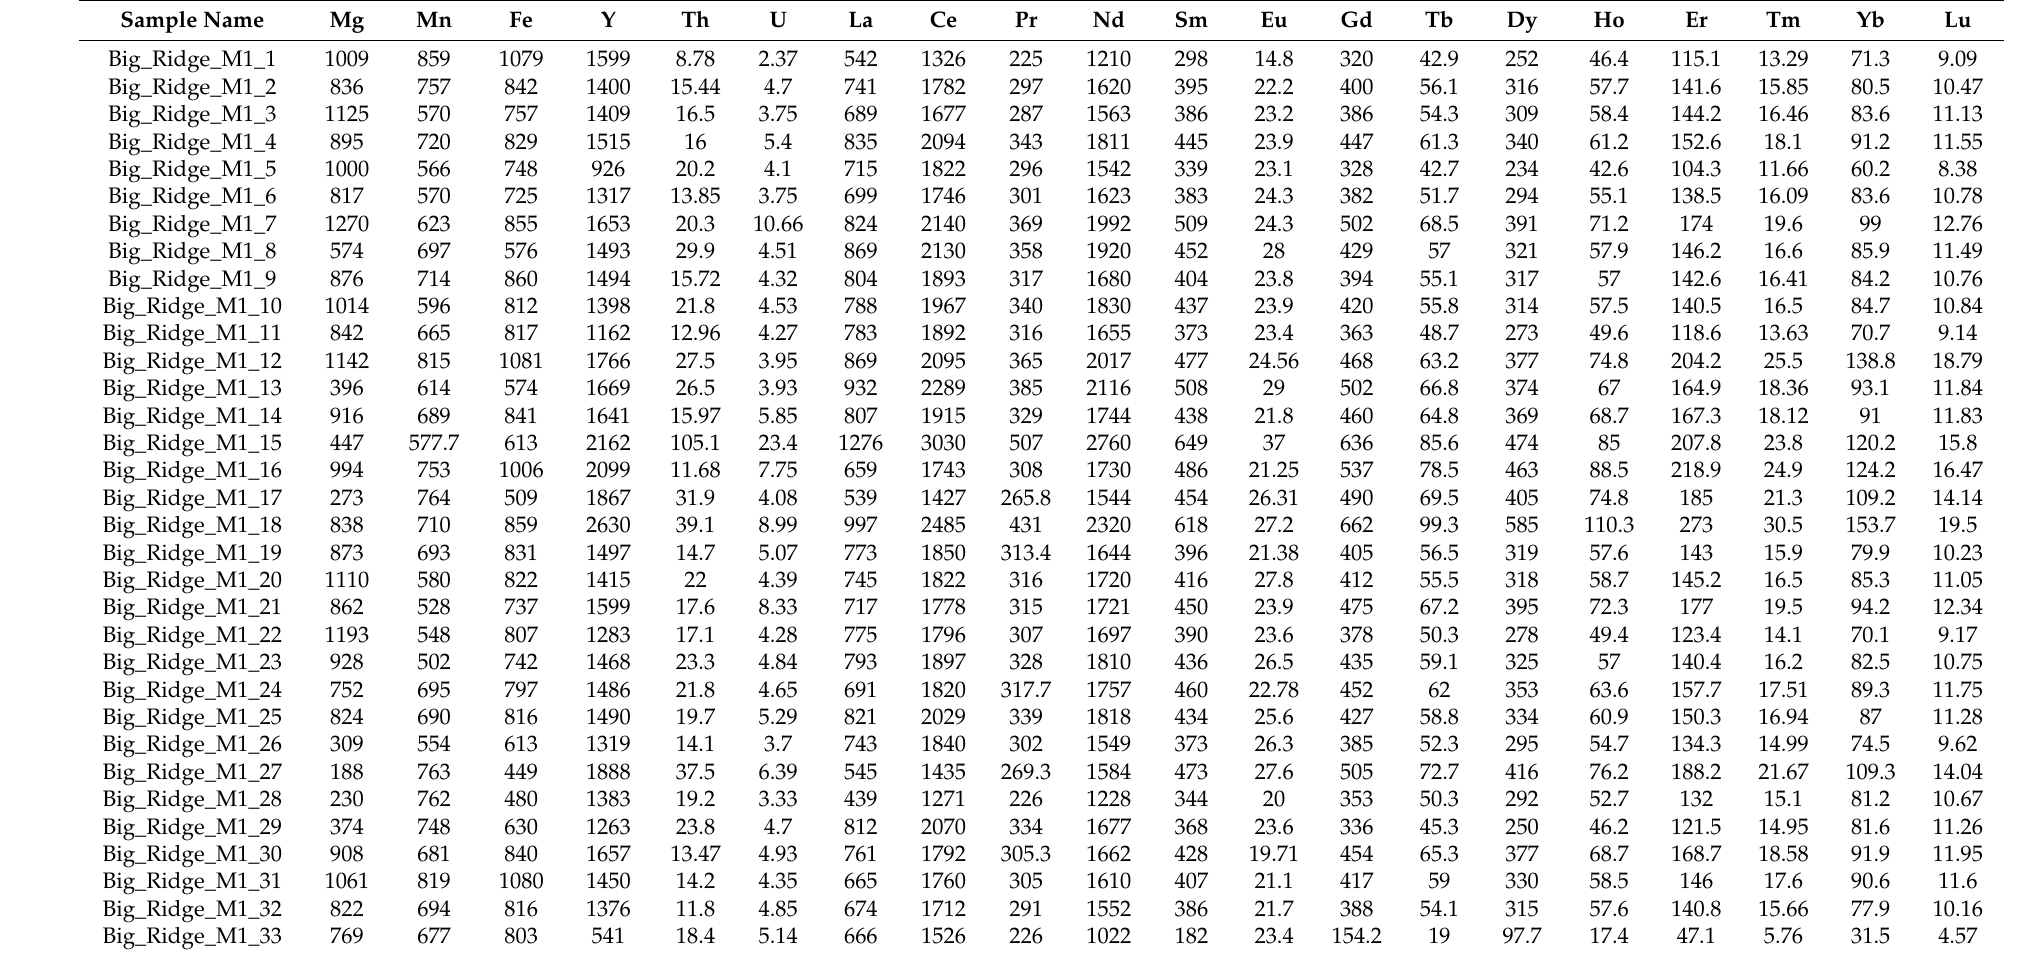
Table A1. Results from the LA-ICP-MS analyses used as the training set. All elemental abundances are given in